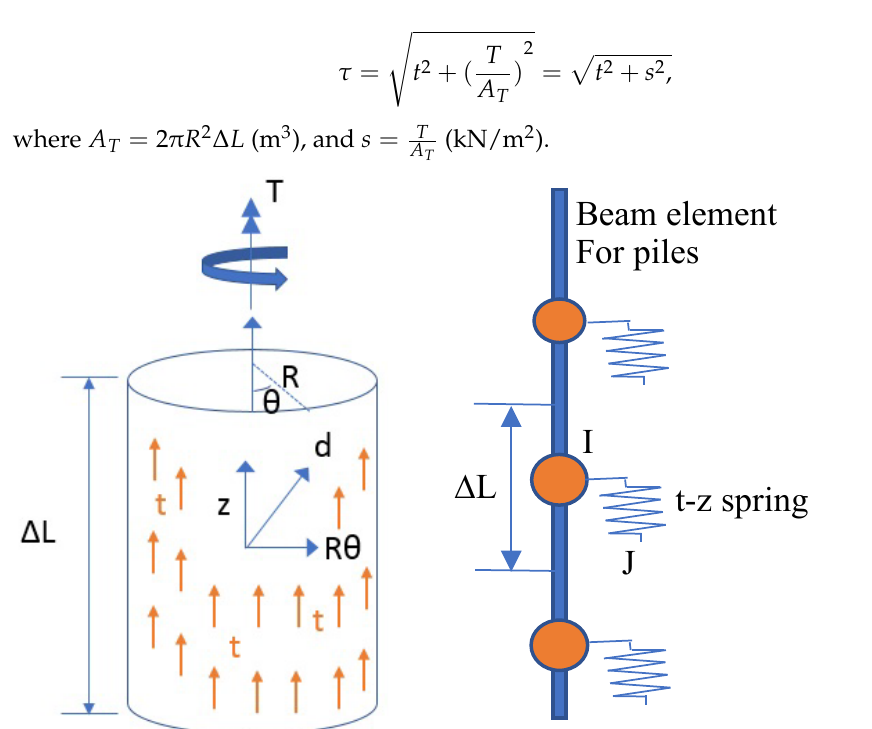
Figure 1. The t-z curve finite element, including the shear and torsional effects.